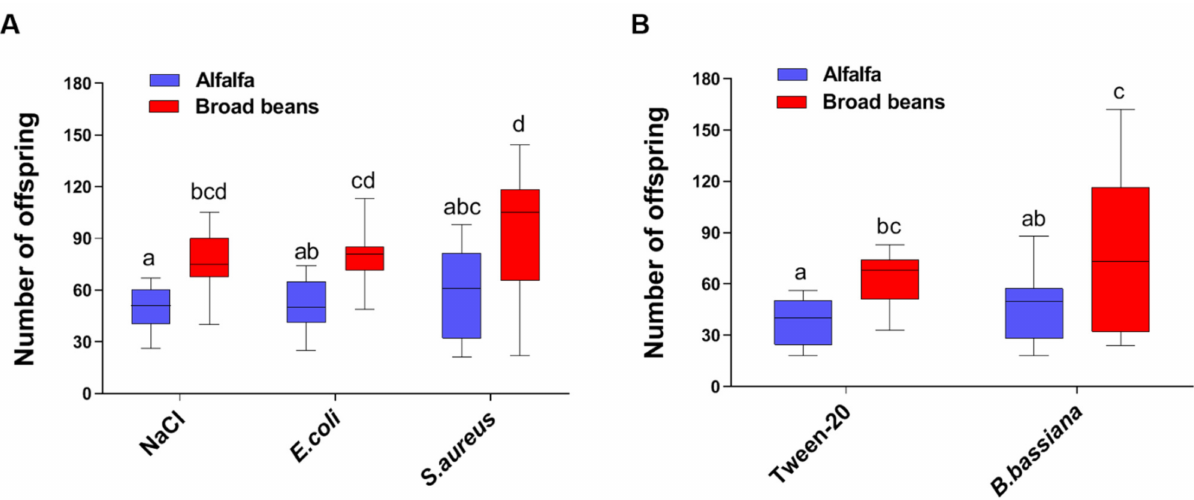
Figure 1. Effect of bacterial and fungal infections on the fecundity of adult pea aphids feeding on different host plants. Shown are the total number of offspring produced in three consecutive days after challenging the adult aphids with bacteria ( A ) and fungus ( B ) ( n = 9). The box and whiskers plots indicate the minimum to a maximum number of offspring. The horizontal lines indicate the mean values, and the vertical bars indicate the SE of the repeats. Different letters between groups indicate p <